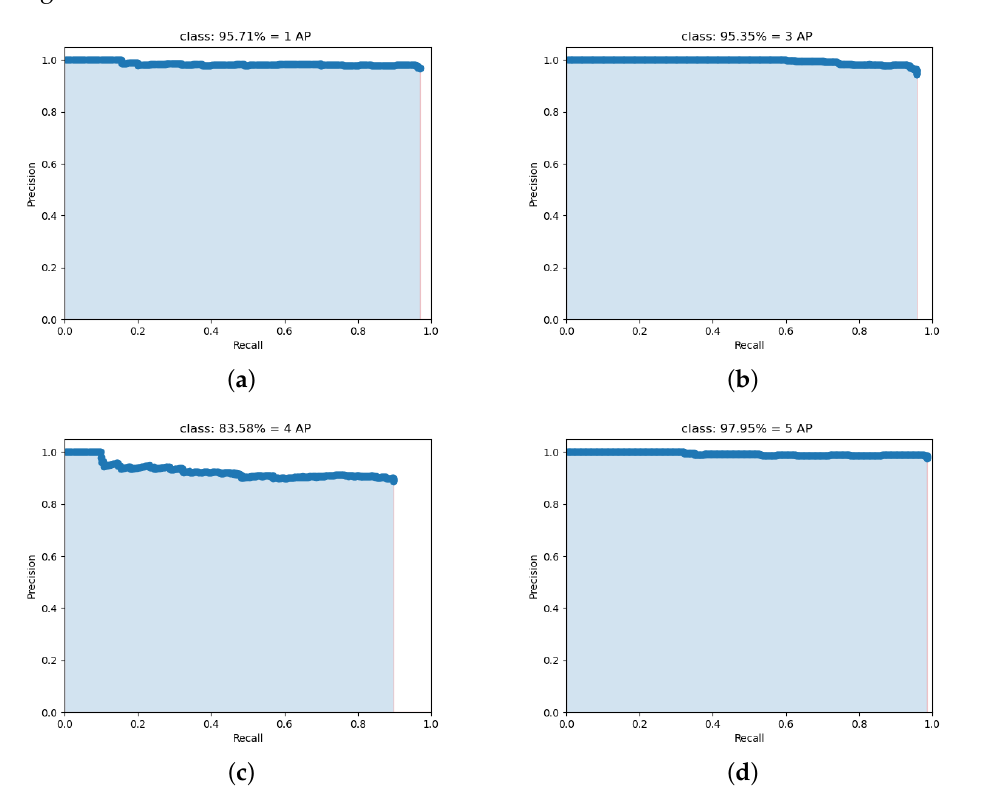
Figure 11. The PR curves of four types of UAVs. ( a ) The PR curves of UAV 1; ( b ) The PR curves of UAV 3; ( c ) The PR curves of UAV 4; ( d ) The PR curves of UAV